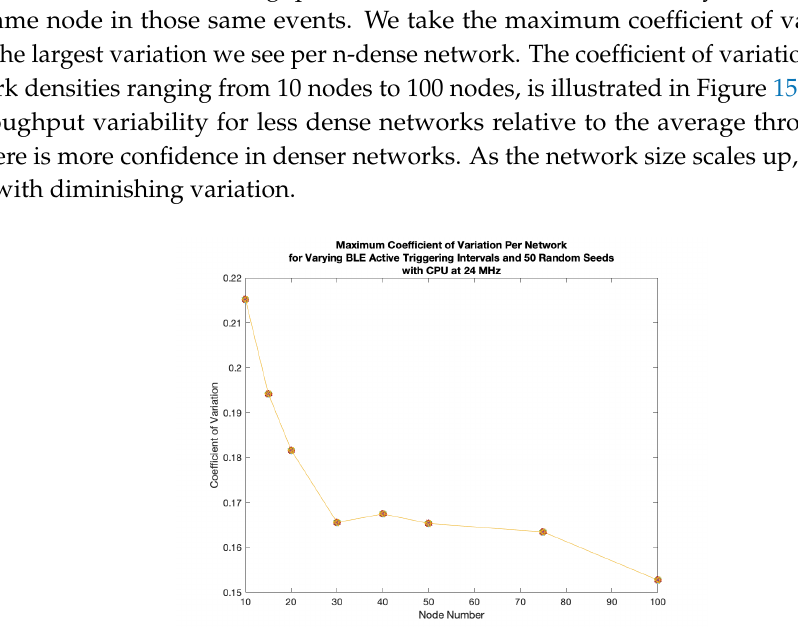
Figure 15. Maximum coefficient of variation per network for varying BLE active triggering